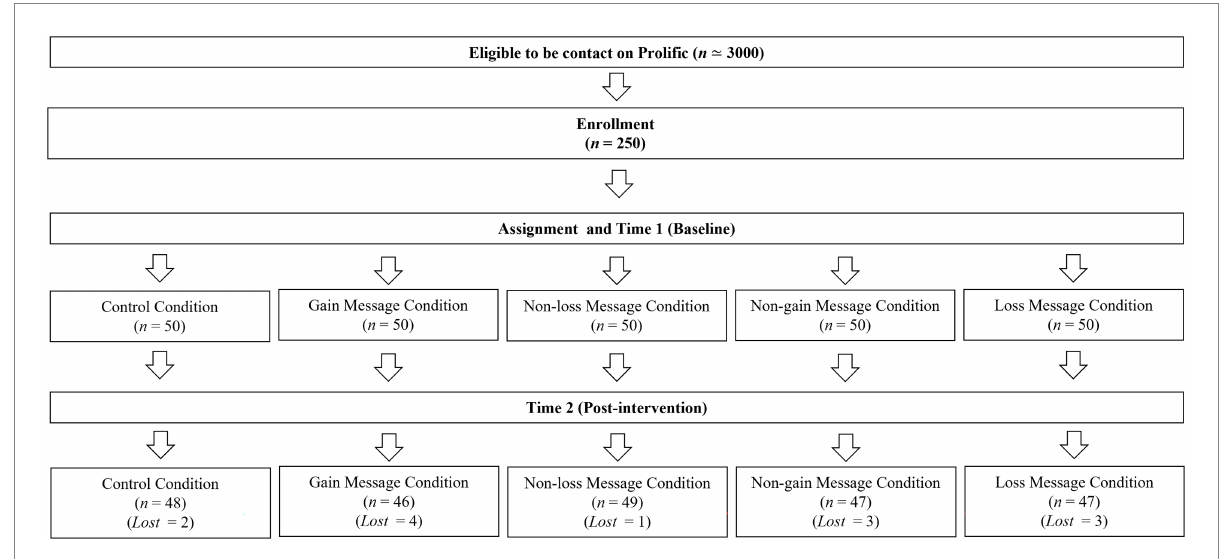
FIGURE 1 Flow chart of participants’